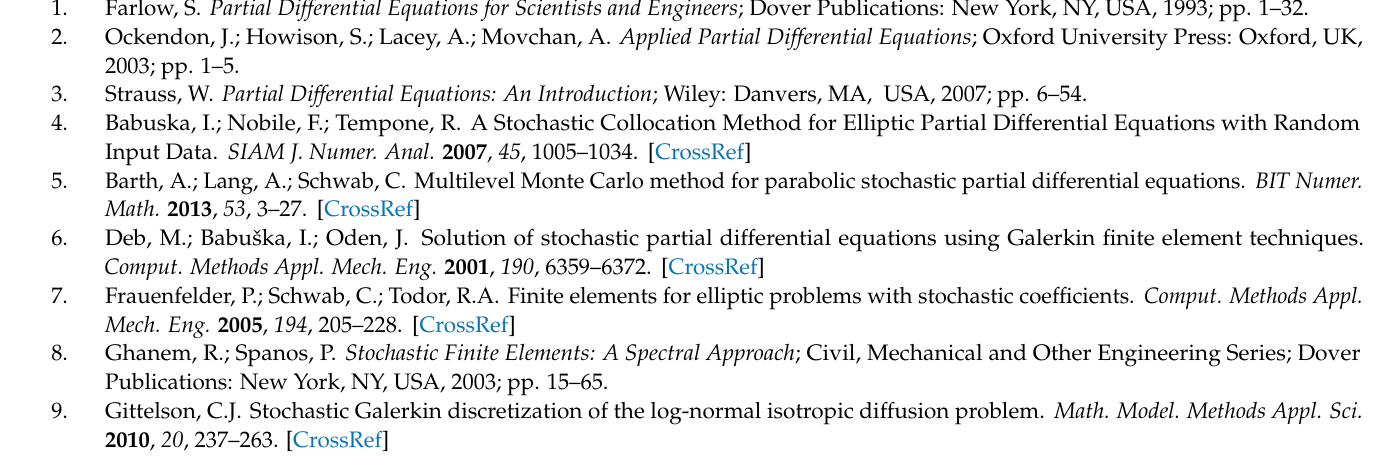
Figure A3. Mean temperature realizations E [ T ∗ ( u ∗ 10 − 5 ; ( a ) OA , t = 0.025; ( b ) OA , t = 0.2; ( c ) OA , t = 0.5; ( d ) OA , t = 1.0; ( e ) IA , t = 0.025; ( f ) IA , t = 0.2; ( g ) IA , t = 0.5; ( h ) IA , t =